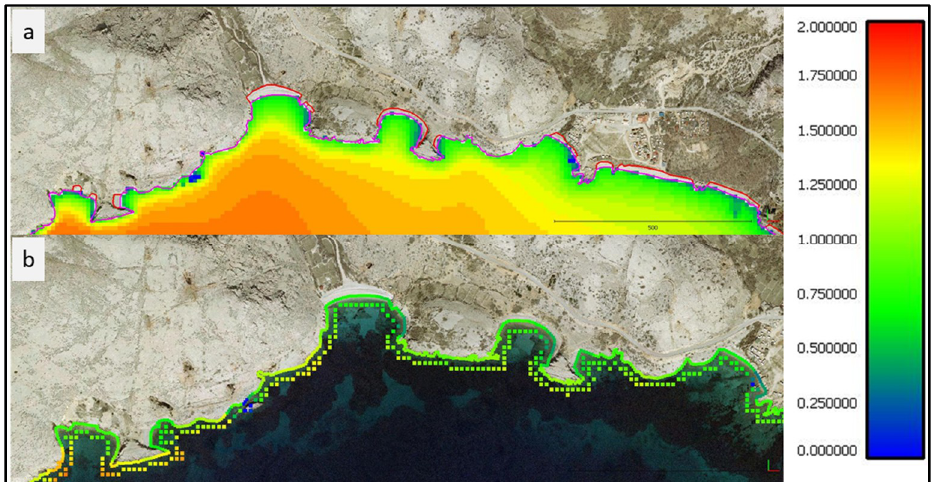
Figure 7. ( a ) The SE Significant wave height (H S ); ( b ) 15 m from the coastline and its values associated with the defined coastline station.